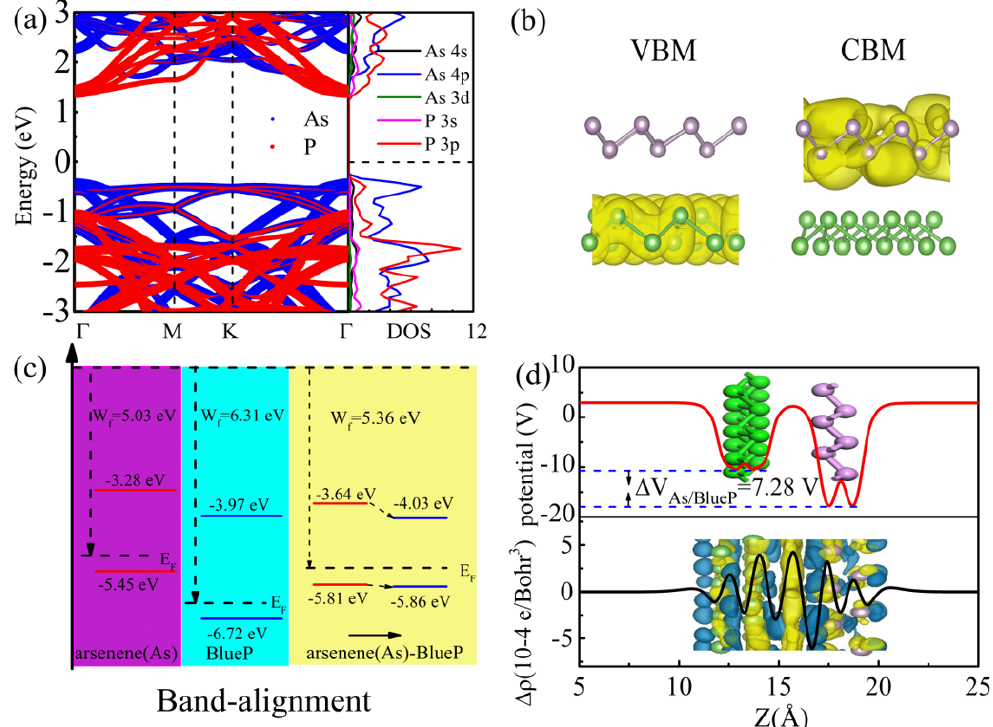
Figure 3. ( a ) Projected band structure and DOS of the As/BlueP hetero-structure based on HSE06 exchange-correlation functional. ( b ) Isosurface plot of real space charge distribution at CBM and VBM of the hetero-structure with isovalue equal to 0.002 e/Bohr 3 . ( c ) Band edges and band alignment of monolayer As, monolayer BlueP and the As/BlueP hetero-structure. ( d ) The electrostatic potential and plane-averaged differential charge density of the As/BlueP hetero-structure along z-direction.